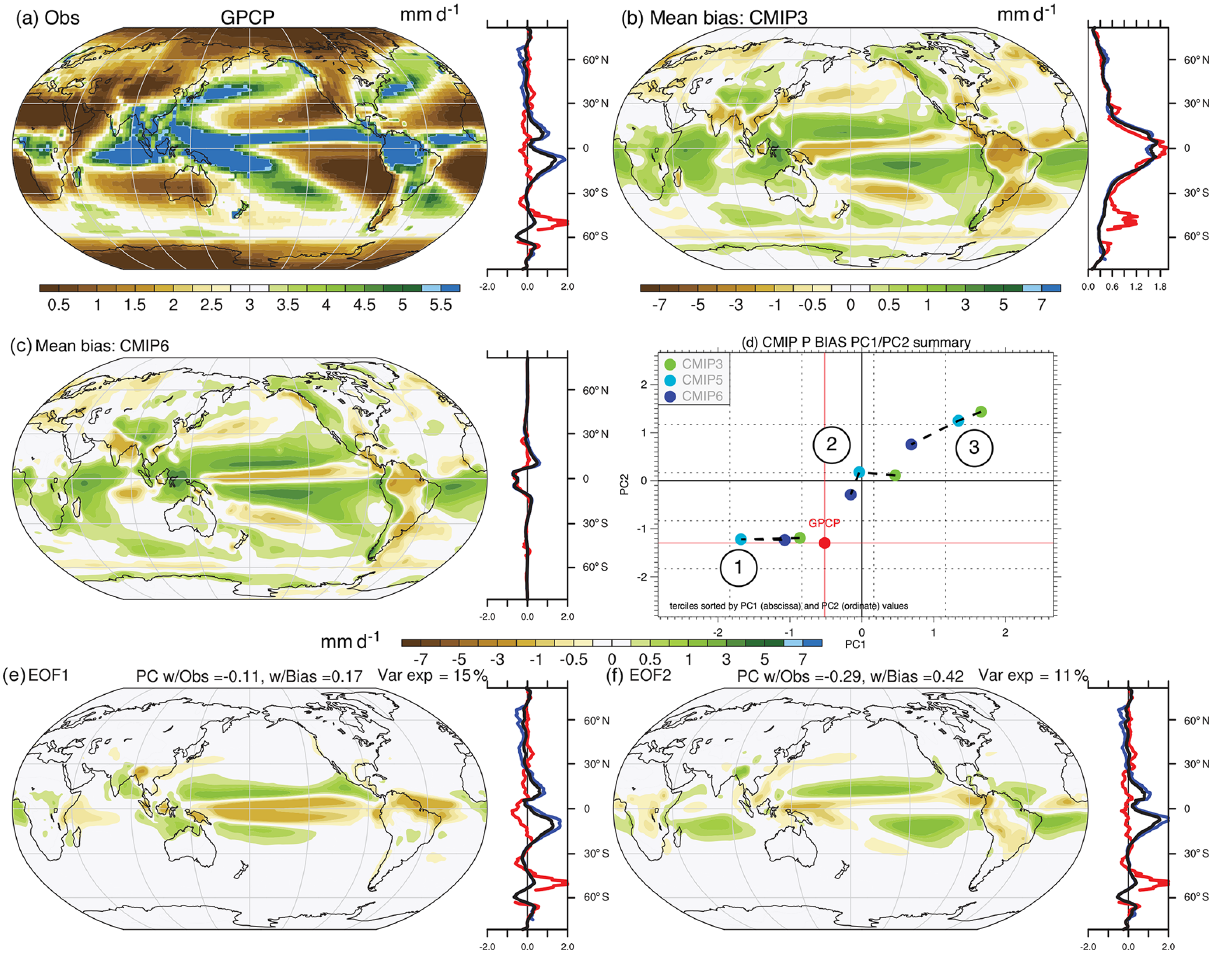
Figure 8. Analysis of the annual mean precipitation bias in the combined historical CMIP3/5/6 archive including the following: (a) the observed estimate from GPCP CDR; the mean biases in (b) CMIP3 and (c) CMIP6; and (d) the first two PCs of biases and their tercile averages across the CMIP archives and the associated (e) first and (f) second EOFs of biases. All units are millimeters per day (mmd − 1 ), except for the PCs, which are unitless. Zonal means (right panels) include land (red), ocean (blue), and global